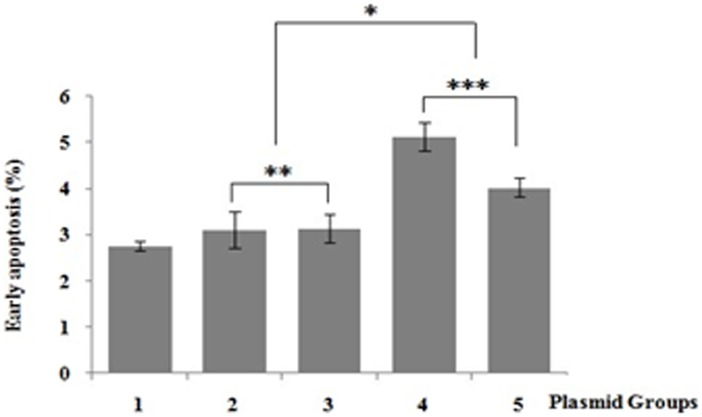
Early apoptosis rate in HEK293 cells.Plasmid Groups: 1. pcDNA3.1-myc-His(-)B; 2. pcDNA3.1-myc-His(-)B-ataxin-3-20Q; 3. pcDNA3.1-myc-His(-)B-ataxin-3-20QK166R; 4. pcDNA3.1-myc-His(-)B-ataxin-3-68Q; 5. pcDNA3.1-myc-His(-)B-ataxin-3-68QK166R. Statistical significance was assessed with a one-way ANOVA: 2 and 4: P<0.05 (*); 2 and 3 P>0.05 (**); 4 and 5: P<0.05 (***).